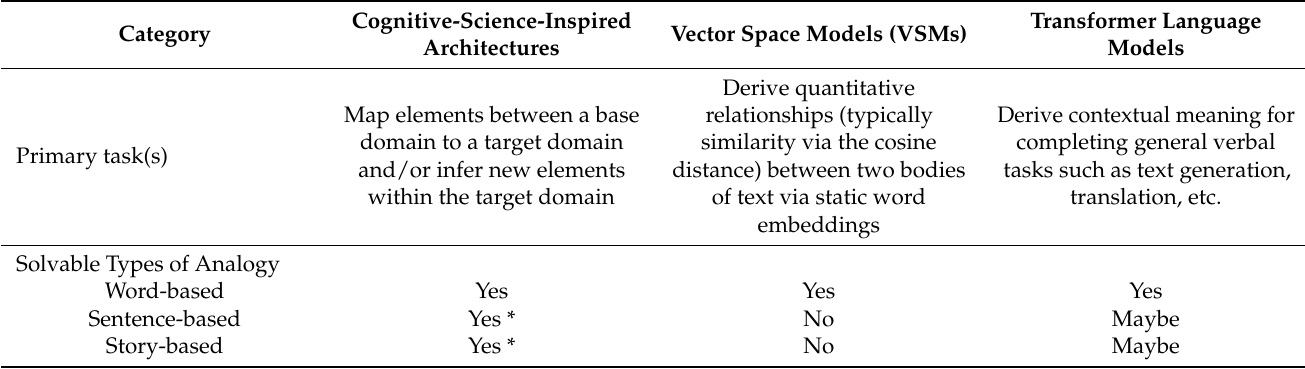
Table 3. Types of natural language processing algorithms.